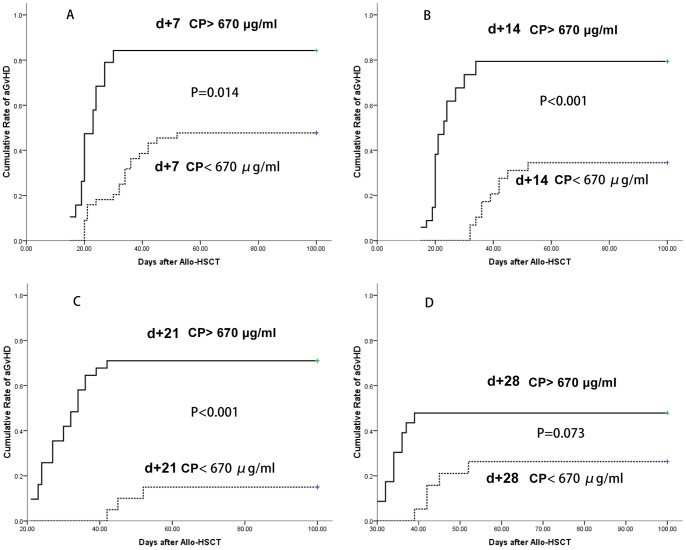
The cumulative incidence of aGvHD at multiple time points.Comparison of cumulative incidence of aGvHD in two groups of patients (CP> 670 μg/ml or <670 μg/ml) at different time points: d+7(p = 0.014), d+14(p<0.001), d+21(p<0.001) and d+28(p = 0.073).